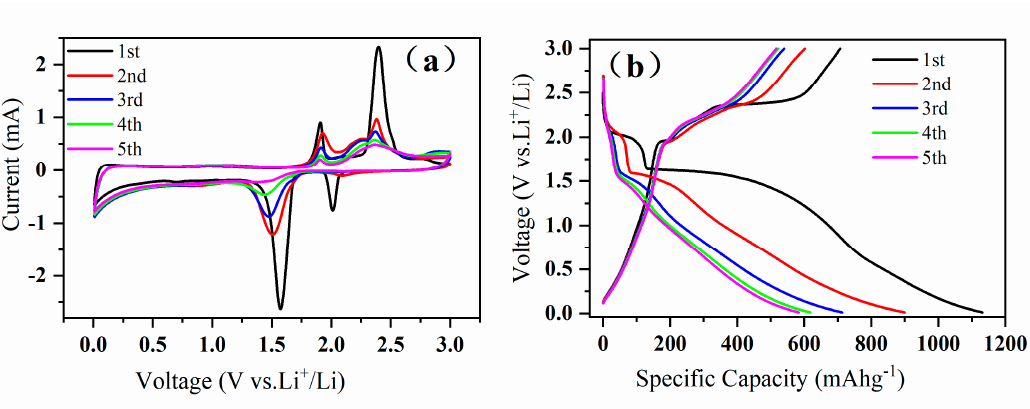
Figure 3. ( a ) The initial five cyclic voltammetry curves with a scanning rate of 0.1 mV s − 1 and in a potential range between 0.01 V and 3.0 V. ( b ) The initial five discharge and charge curves at a current density of 267 mA g − 1 .